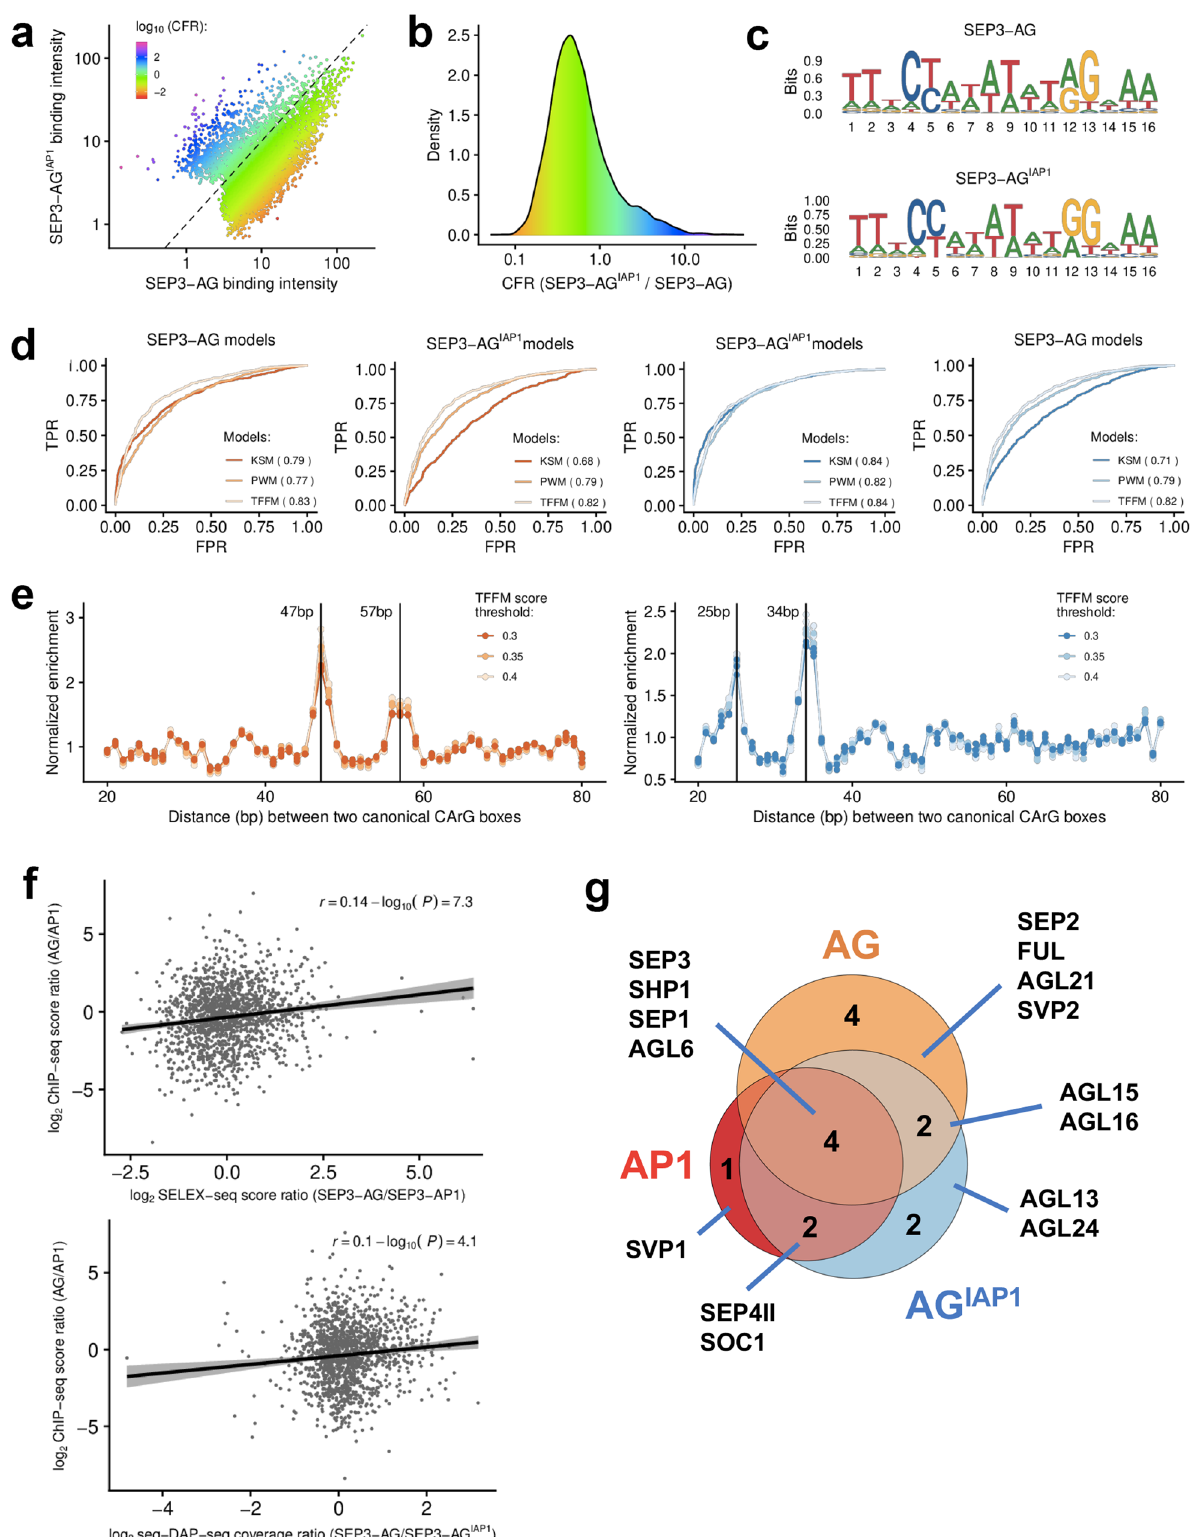
phenotype as AG MAP1 (Fig. 5b, panel 3). Strikingly, AG IAP1 (Fig. 5b, panel 4) expressing plants exhibited four sepaloid organs and three to four petals or petaloid organs in more than half of the plants, suggesting that the I domain acts as the smallest unit conferring the most AP1 function to the AG IAP1 chimera (Supplementary Table